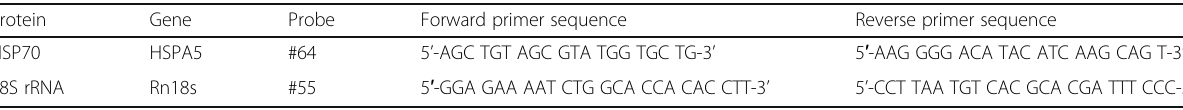
Table 1 Primers and probes used in the real-time PCR Protein